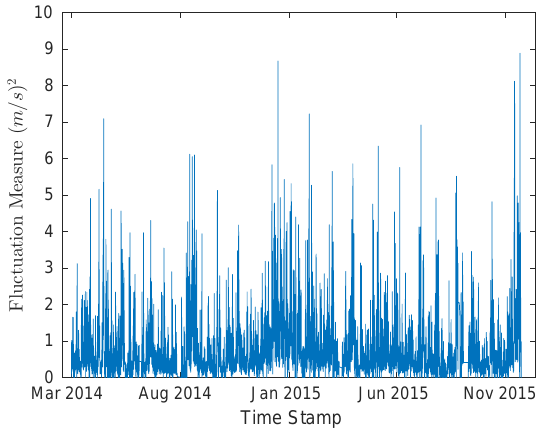
Figure 2. Wind speed fluctuation time series at wind turbine R01 for a time window length of two hours.